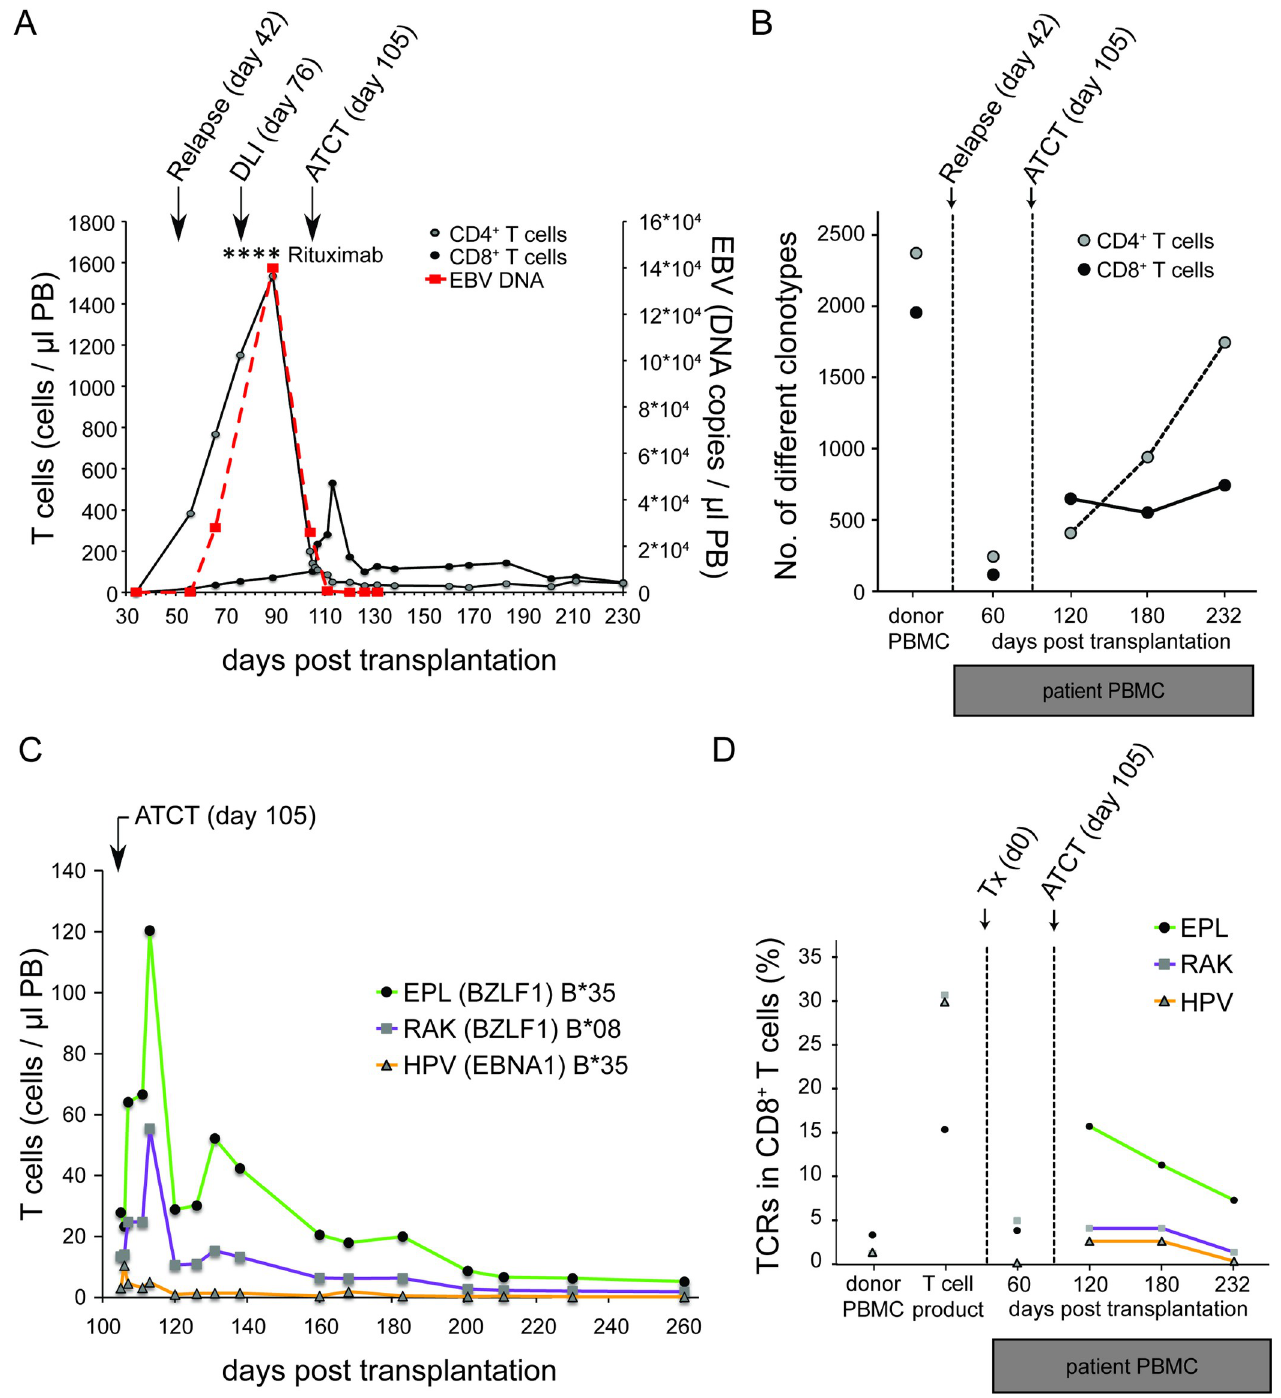
Fig 3. T cell and clonotype expansion after allogeneic stem cell transplantation and adoptive transfer of EBV-specific T cells. (A) Flow cytometric monitoring of absolute numbers of CD4 + and CD8 + T cells and EBV DNA copy number in peripheral blood. Relapse of the CD4 + T cell lymphoma was detected on day 56 in peripheral blood. Time points of Rituximab application are marked with an asterisk ( � ). ATCT = adoptive T cell transfer. (B) TCR clonotype diversity in CD4 + and CD8 + T cells in peripheral blood of the patient. For comparison, the diversity in donor’s PBMC is shown. (C) Flow cytometric monitoring of peripheral blood CD8 + T cells using HLA peptide-MHC multimers (EPL, RAK, HPV) on the day of ATCT (day 105) and thereafter. (D) Cumulative frequency of TCR clonotypes specific for each of the epitopes EPL, RAK, and HPV in CD8 + T cell populations. Data points for donor’s PBMC, T cell product after peptide stimulation, and peripheral blood of the patient before (day 60) and after ATCT (day 120, day 180, and day 230) are shown.